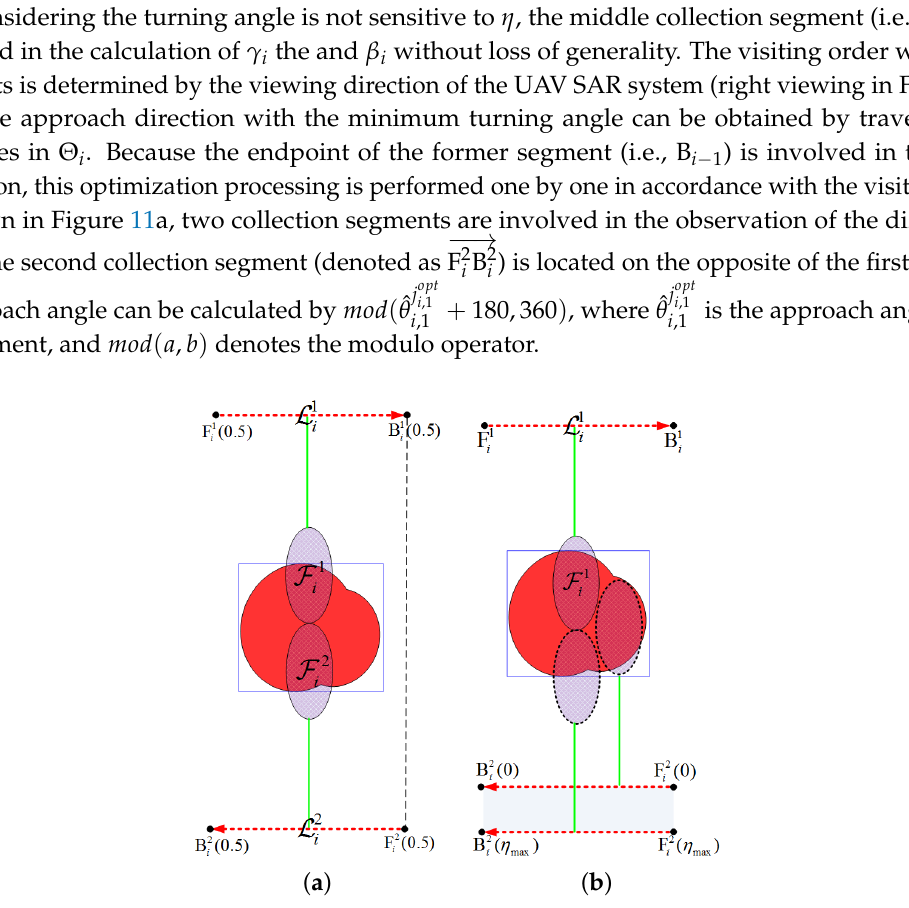
Figure 11. Illustration of localizing collection segments for the distributed ROI. The second segment is located on the opposite of the first one, i.e., ˆ θ the optimal approach angle; ( b ) η max used in searching the optimal scalar of the second collection segment is restricted by the first